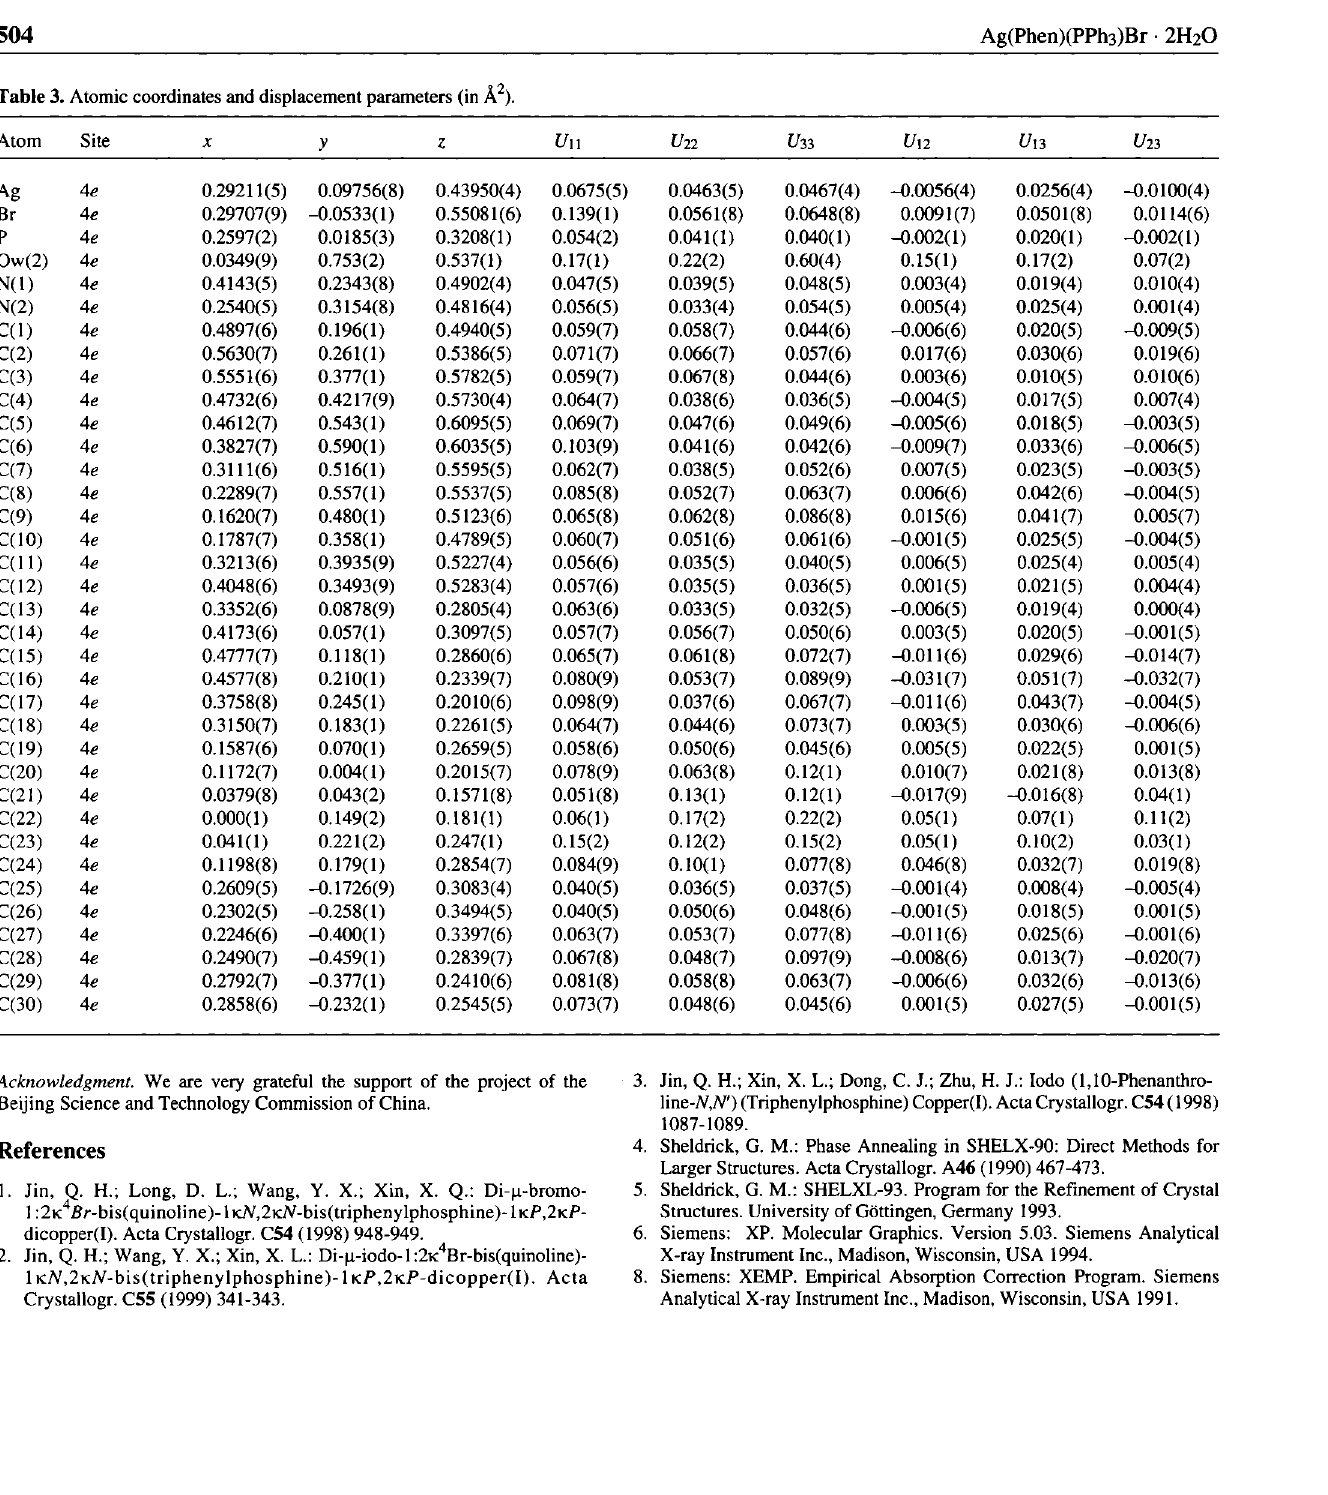
Table 3. Atomic coordinates and displacement parameters (in Ä 2 ).